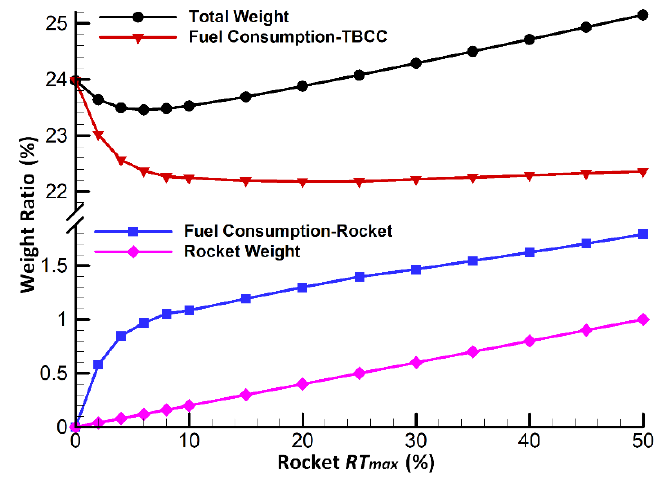
Figure 9. Rocket RT max vs. weight consumption.